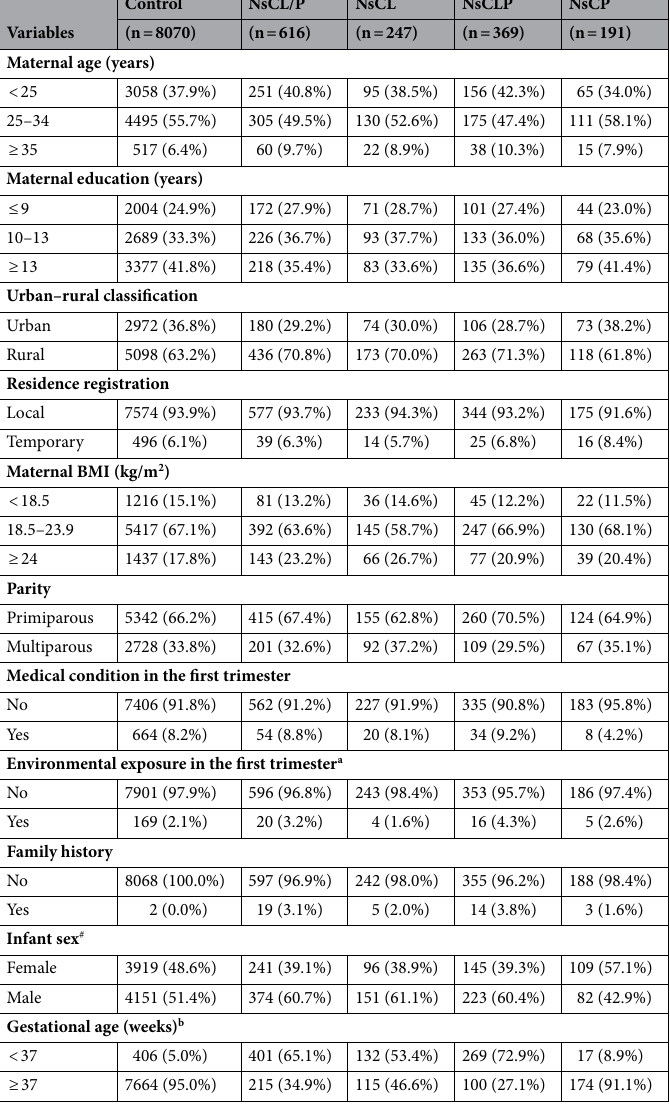
Table 1. General characteristics of the study subjects. NsCL/P, nonsyndromic cleft lip with or without cleft palate cases; NsCL, nonsyndromic cleft lip cases; NsCLP, nonsyndromic cleft lip with cleft palate cases; NsCP, nonsyndromic cleft palate cases. # The infant sex records with one missing value on NsCLPs. a The environmental exposure in the first trimester was whether the mothers had smoking, alcohol drinking, drug abuse, or exposure to radiation and hazardous substances in the first trimester. b For those cases of termination of pregnancy, their gestational age at the time of termination of pregnancy were regarded as birth